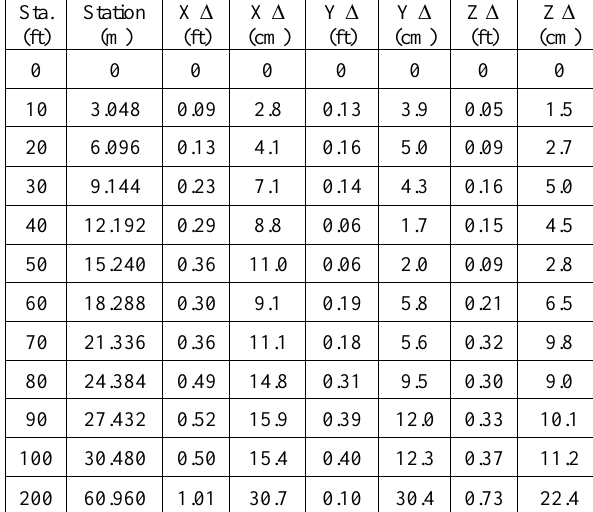
Table 1. Differences between LiDAR point cloud points